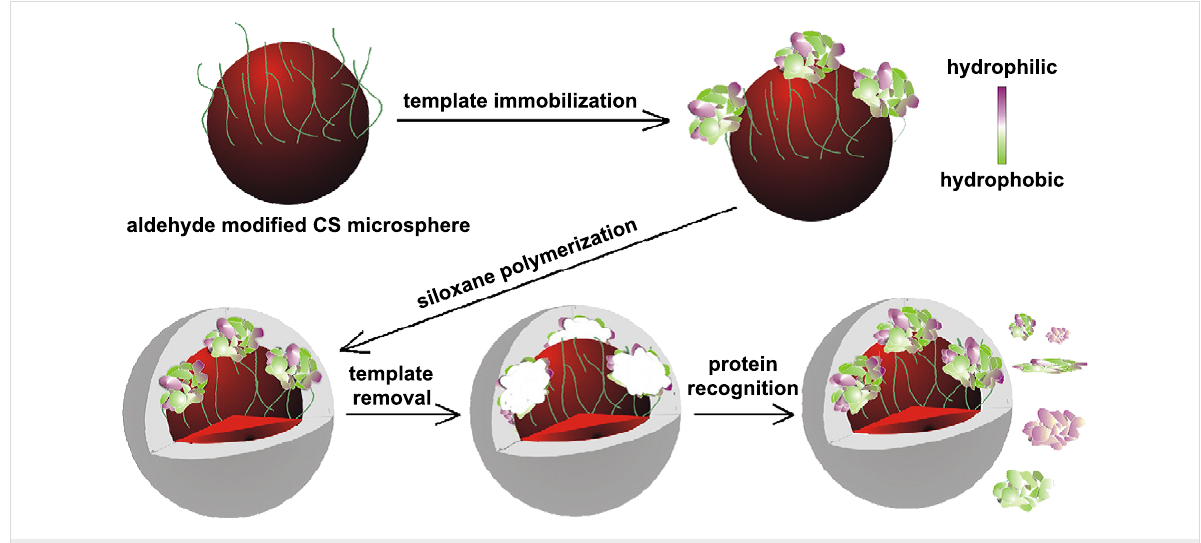
Figure 4: Siloxan polymerization on chitosan microspheres by using immobilized protein templates. Reprinted with permission from [61]. Copyright 2008